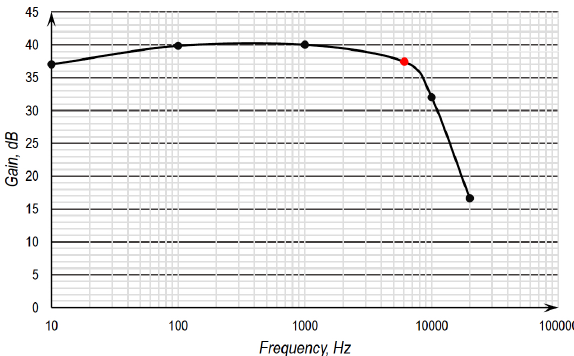
Figure 13. Frequency response of the designed sensor where the cutoff frequency was at 6.1